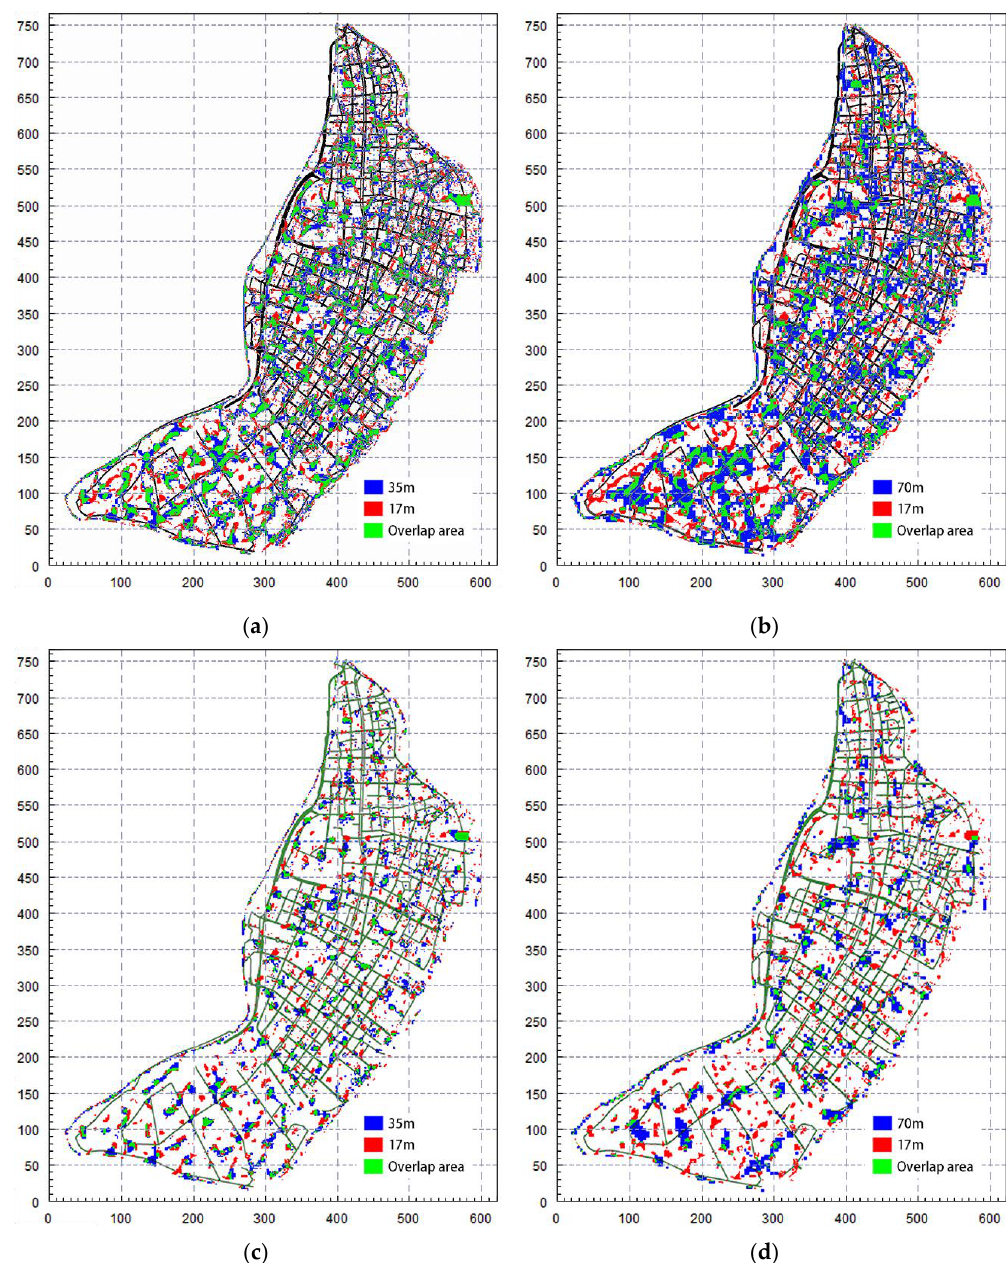
Figure 7. Contrast results of simulated inundation area: ( a ) cases C1 and C3; ( b ) cases C1 and C4; ( c ) cases C2 and C5; ( d ) cases C2 and C6.